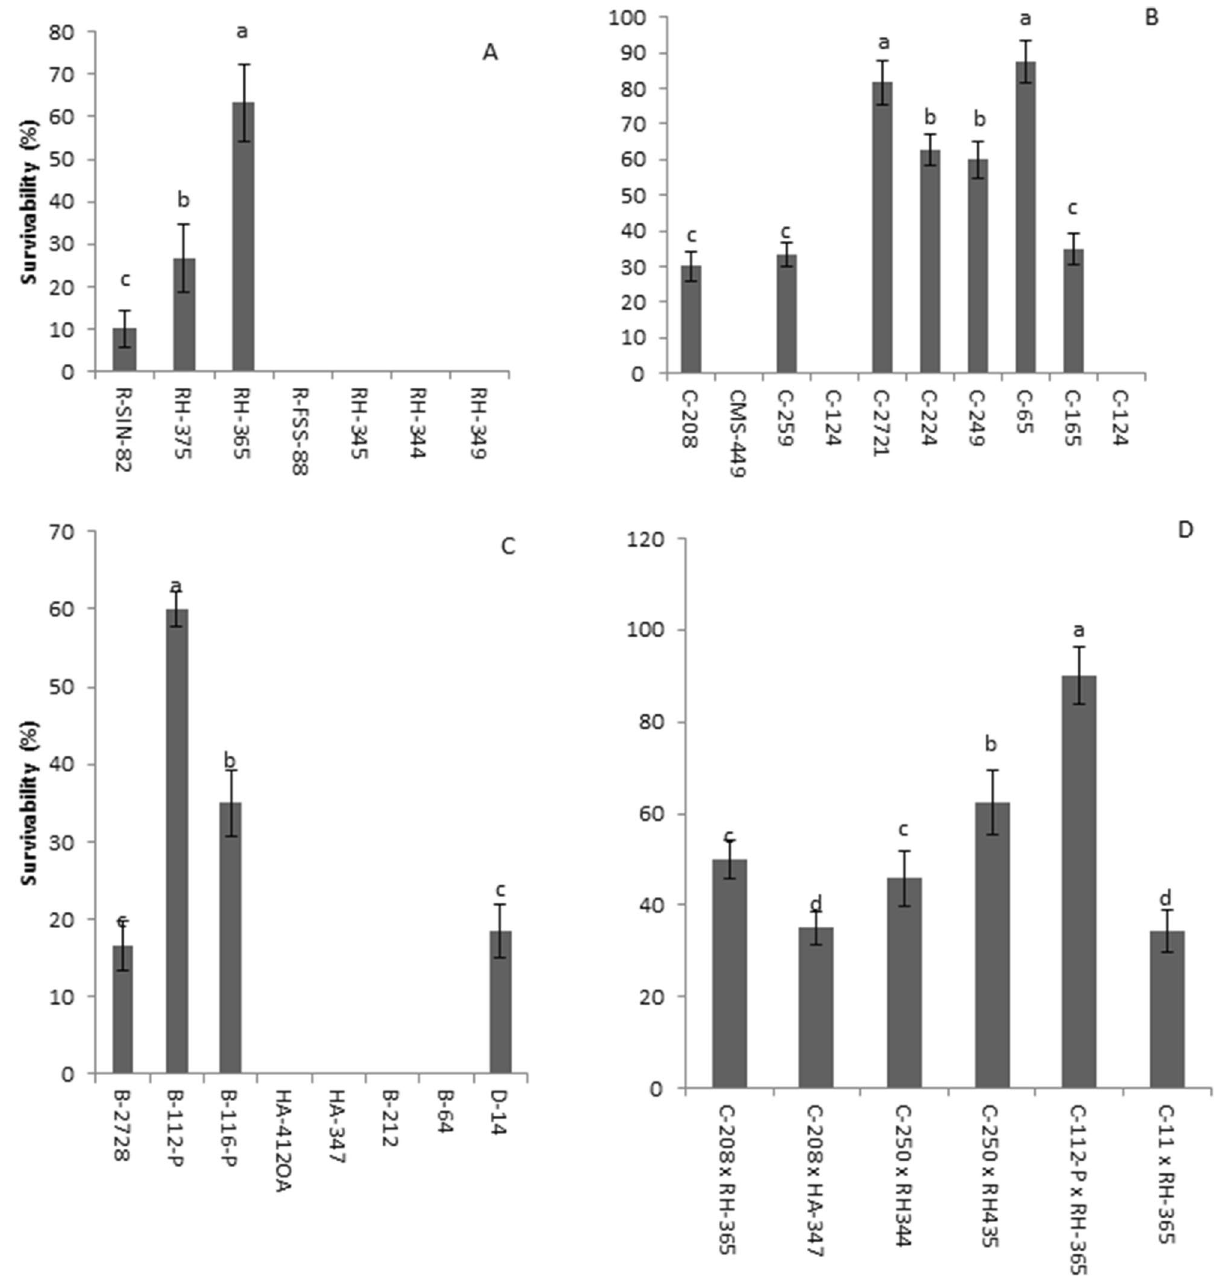
Figure 2. Mean survivability ± standard bar of various sunflower accessions. ( A ) Restorer populations. ( B ) Maintainer. ( C ) Cytoplasmic male sterile lines. ( D ) Cross